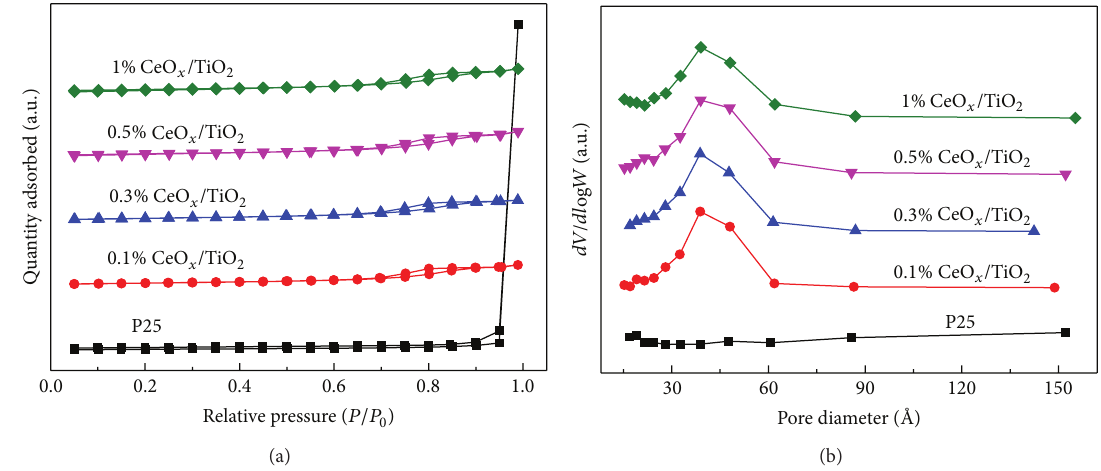
Figure 6: (a) Nitrogen adsorption-desorption isotherms of P25 and 𝑥 % CeO 𝑥 /TiO 2 nanoparticles; (b) BJH pore-size distributions of P25 and 𝑥 % CeO 𝑥 /TiO 2